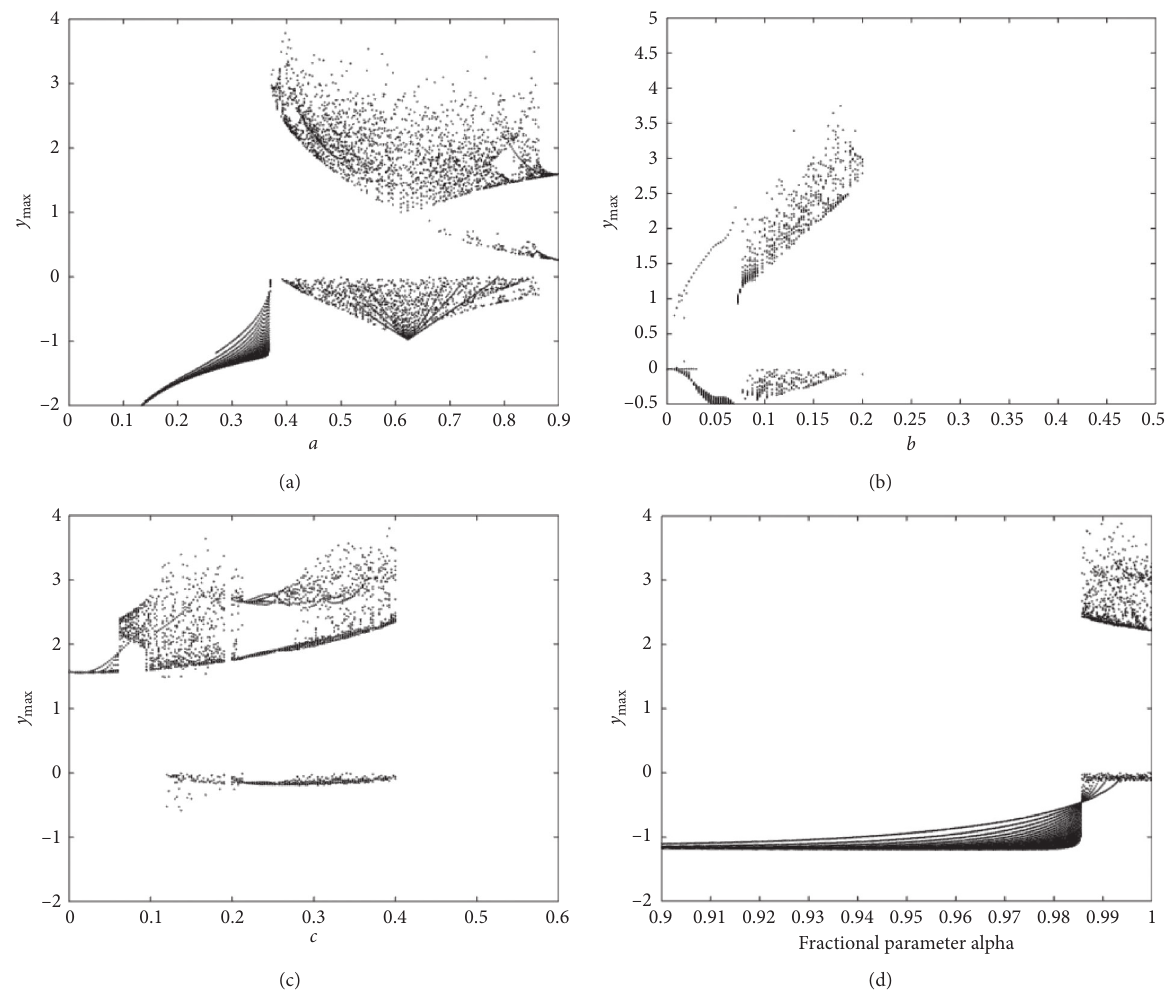
Figure 2: Bifurcation diagram of FOS model (20) as varying (a) a with b � 0 . 175 ,c � 0 . 4 , and α � 0 . 99; (b) b with setting a � 0 . 4 ,c � 0 . 4 , and α � 0 . 99; (c) c with setting b � 0 . 175 ,a � 0 . 4 , and α � 0 . 99; (d) α with setting a � 0 . 4 ,b � 0 . 175 , and c � 0 . 4.